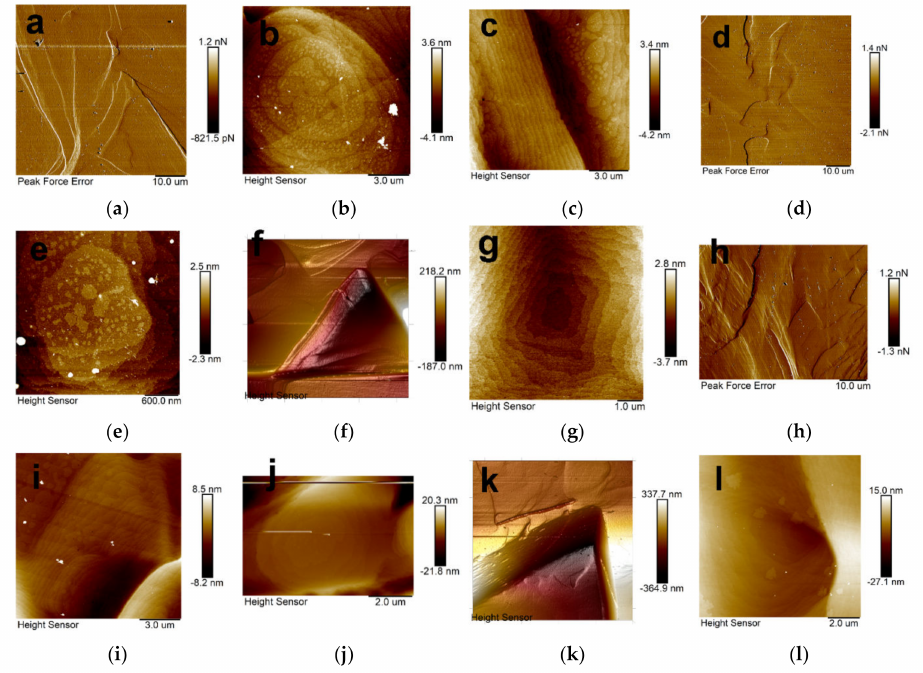
Figure 5. Microtopography of (101) faces of KDP crystals grown in [101] direction under high supersaturation: ( a ), ( b ), ( c ) σ = 3.94%; ( d ), ( e ), ( f ), ( g ) σ = 5.99%; ( h ), ( i ), ( j ), ( k ), ( l ) σ =